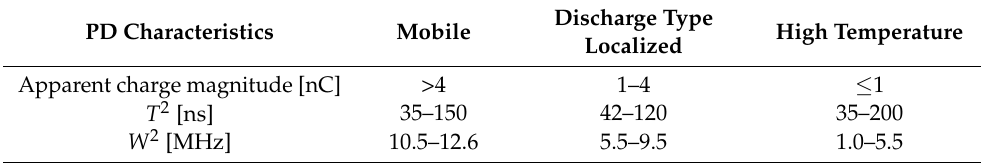
Table 1. Negative DC partial discharge characteristics.